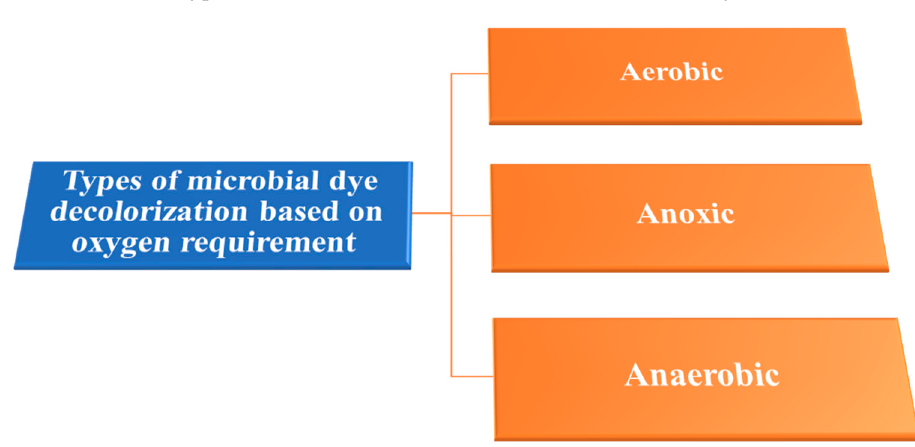
Figure 4. Various types of microbial methods for remediation of textile dyes.